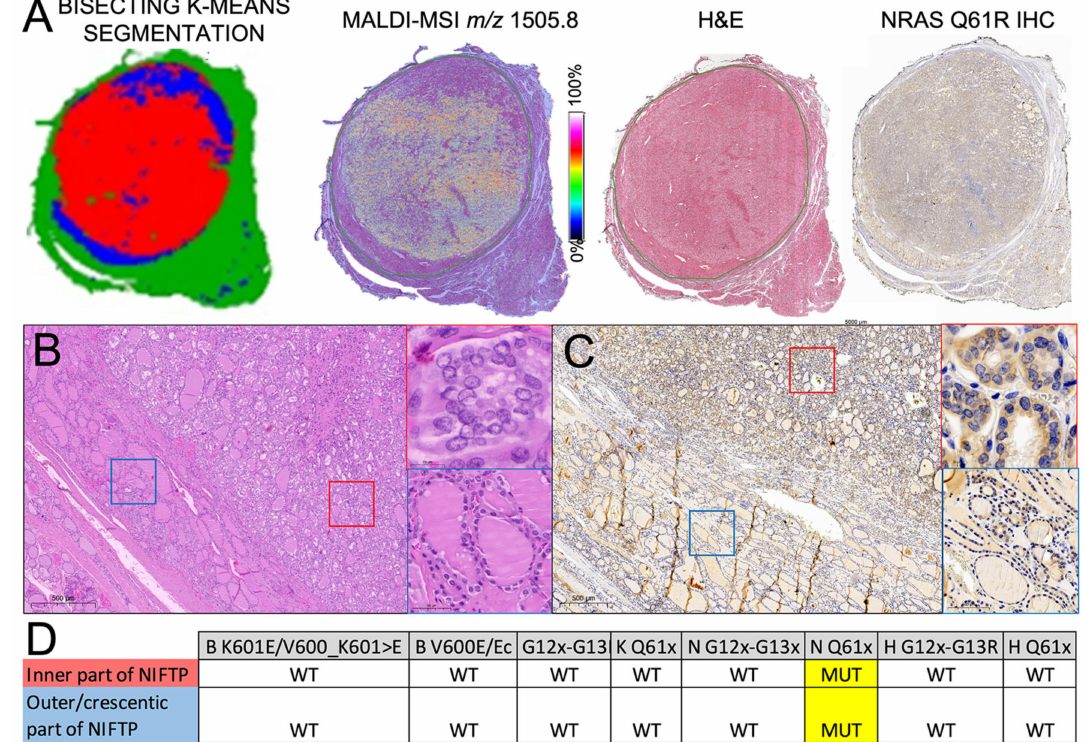
Figure 5. The comparative analysis of images obtained from the K-Means segmentation, MALDI– MSI (based on 1505.8 m/z, PPIA), routine H&E and NRAS Q61R IHC ( A , from left to right) of an emblematic case (#5) demonstrates the presence of intranodular heterogeneity of this NIFTP. In particular, the molecular differences highlighted by the K-Means and MALDI–MSI between the inner part of the nodule and the outer rim are confirmed by morphology, with a more microfollicular growth and clear/overlapped papillary-like nuclei with grooves in the inner ( B , red square) as compared to the more macrofollicular pattern without significant nuclear alterations of the outer part of the lesion, with a goitre-like appearance on H&E (B, blue square). Although the NRAS Q61R IHC shows fainter staining of the outer ( C , blue square) as compared to the inner ( C , red square) part of the nodule, further supporting phenotypic differences of the two regions highlighted by proteomics, the rtPCR analysis after laser-capture microdissection demonstrated an NRAS Q61x mutation in both the components without concurrent genetic abnormalities ( D ). This could be explained by intranodular heterogeneity in a single clonal NRAS-mutant follicular proliferation with overall NIFTP characteristics. See Supplementary Materials to evaluate the whole slide image of the